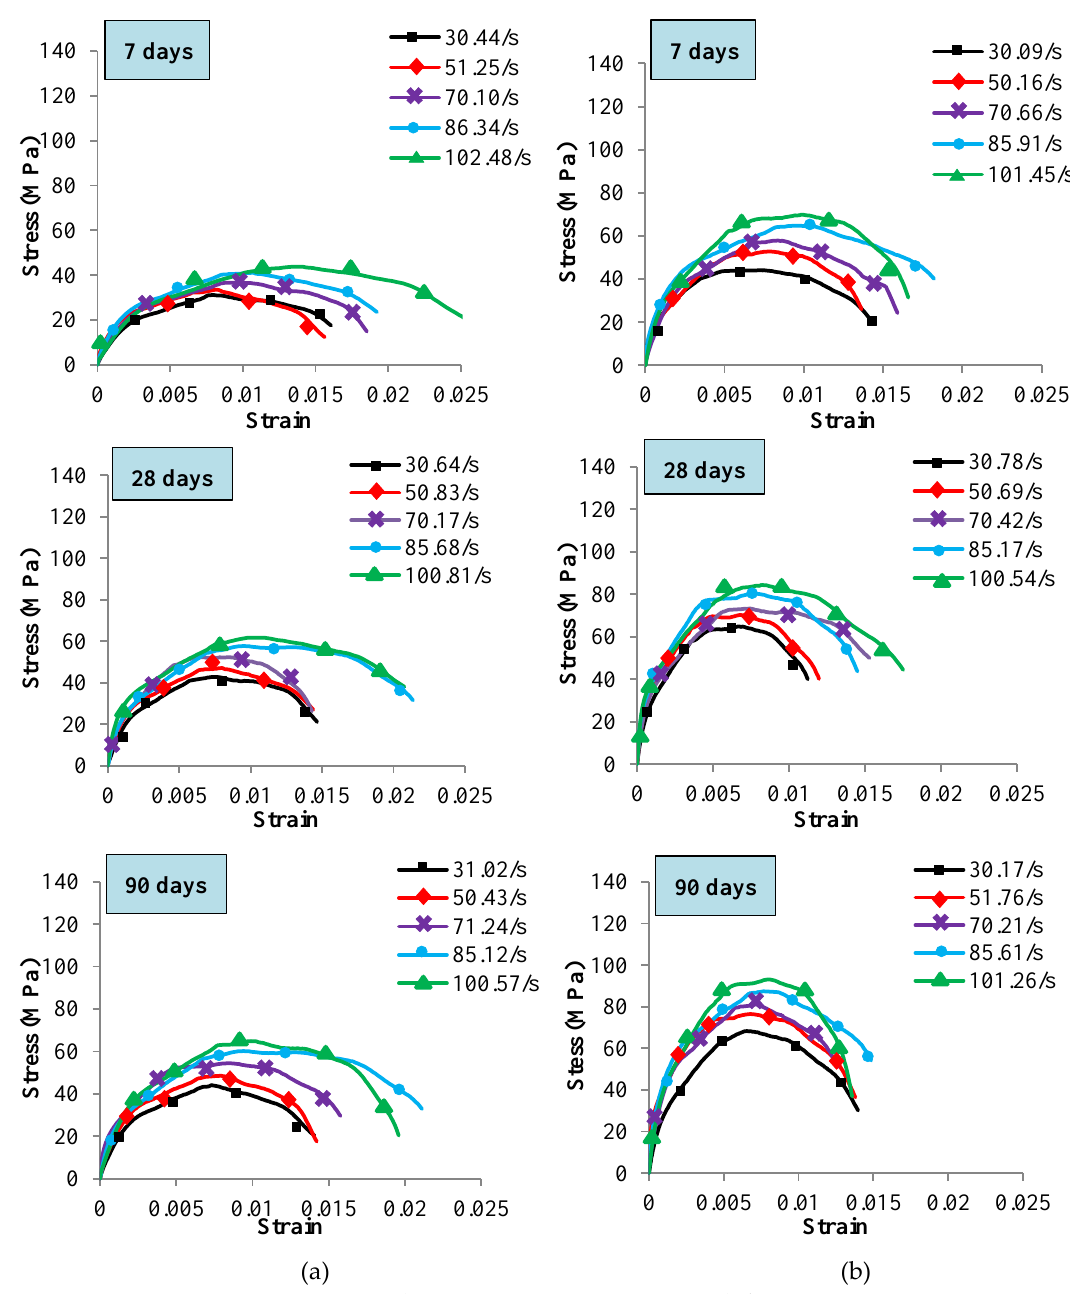
Figure 7. Stress–strain diagrams at 700 °C: ( a ) PC and ( b ) HVFANS concrete.